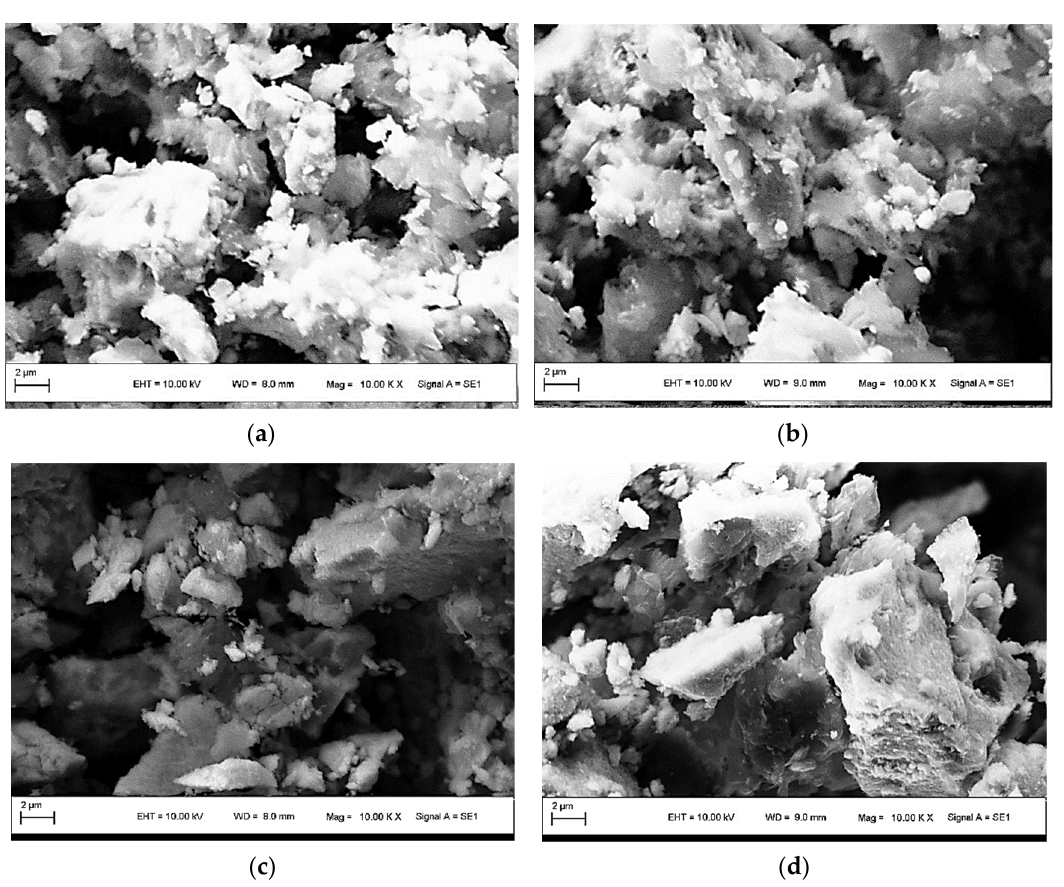
Figure 3. SEM images of TrGO:Fe 3 O 4 nanomaterials: ( a ) Mb 600 , ( b ) Mb 1000 , ( c ) Ma 600 , and ( d ) Ma 1000 .